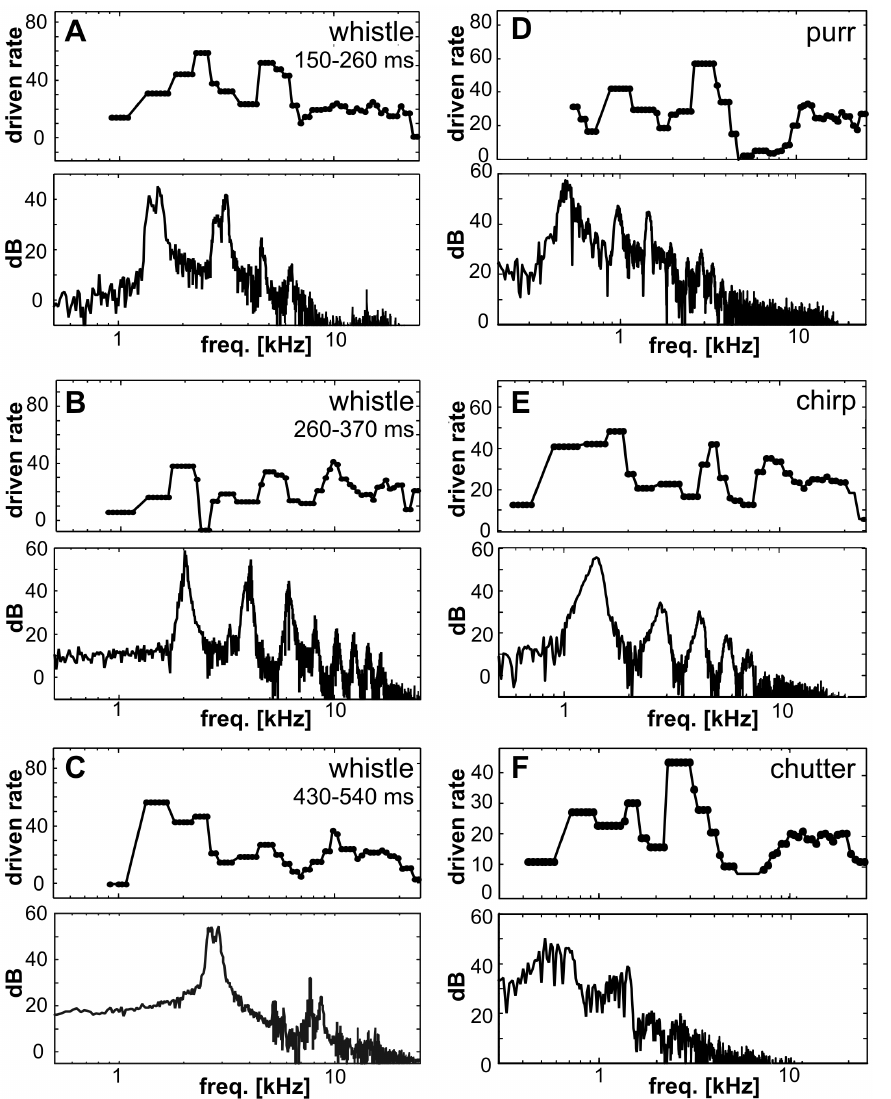
Figure 5. Comparisons of the rate-CF profiles (n=502, top) and call short-term spectra (bottom) for three consecutive parts of whistle (A–C – the appropriate time interval is indicated above every rate-CF profile), for purr (D – data calculated over the first phase containing four elementary phrases), for chirp (E) and for chutter (F – calculated over the first phrase of the call).